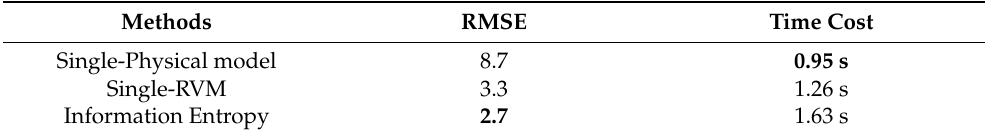
Table 5. Comparison of RMSEs of different lifetime prediction